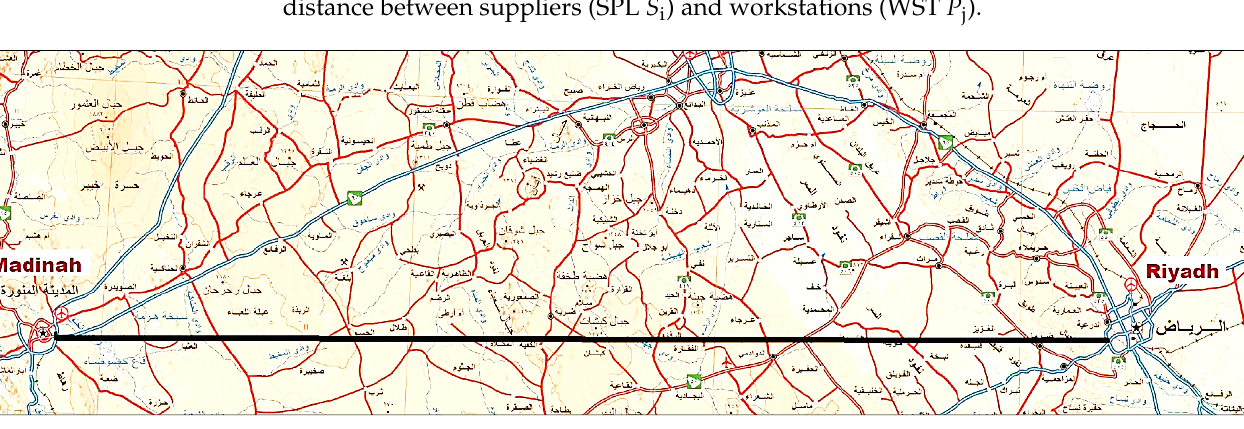
Figure 4. Local routes (in